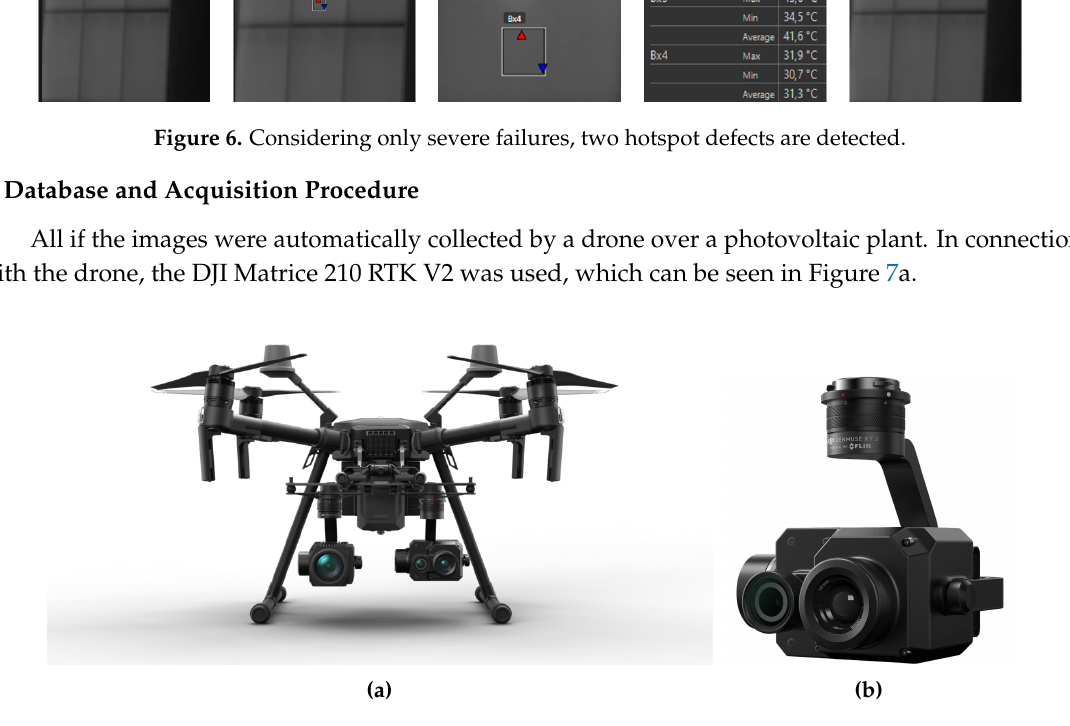
Figure 7. DJI Matrice 210 RTK V2 was used to collect the images from the photovoltaic plant. ( a ) Drone. ( b )